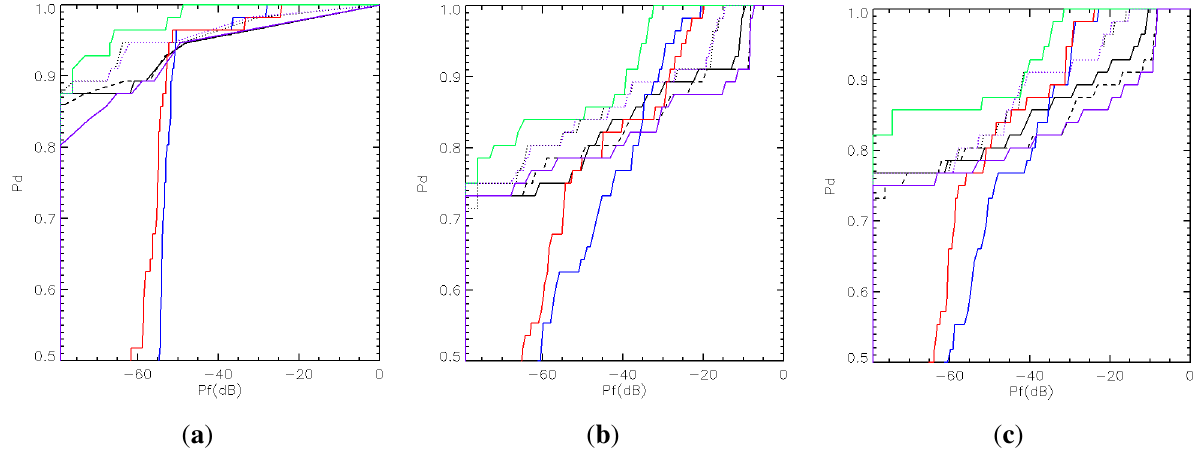
Figure 5. Detector ROC curves for sub-look analysis in the range direction. RADARSAT-2 fine quad-pol data. Boxcar filter: 5 × 9 (range × azimuth) pixels. ( a ) HV channel; ( b ) HH channel; ( c ) VV channel. Vessels analyzed: 69; pixels used for P sub-look correlation (solid: filtered with no overlap; dashed: filtered 30% overlap); blue: sub-look coherence; green: GLRT; violet: intensity (dotted: no average; solid: averaged); red: sub-look